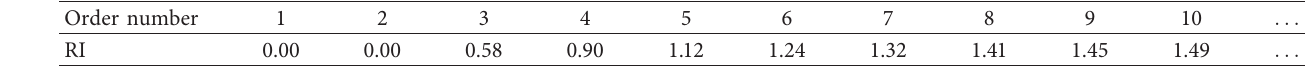
Table 2: The average consistency index, RI index value.